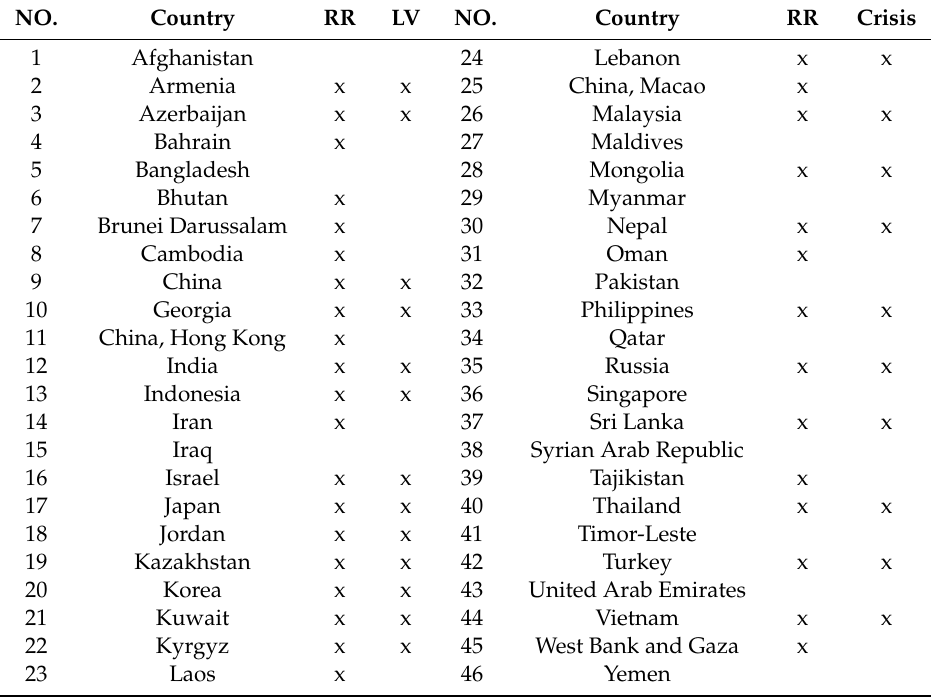
Table A1. List of Countries under Observation in the